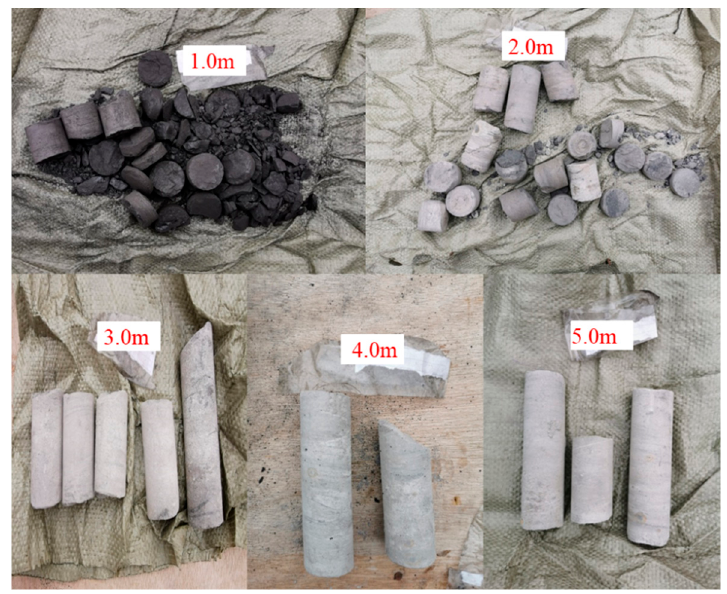
Figure 3. Characteristics of rock core.